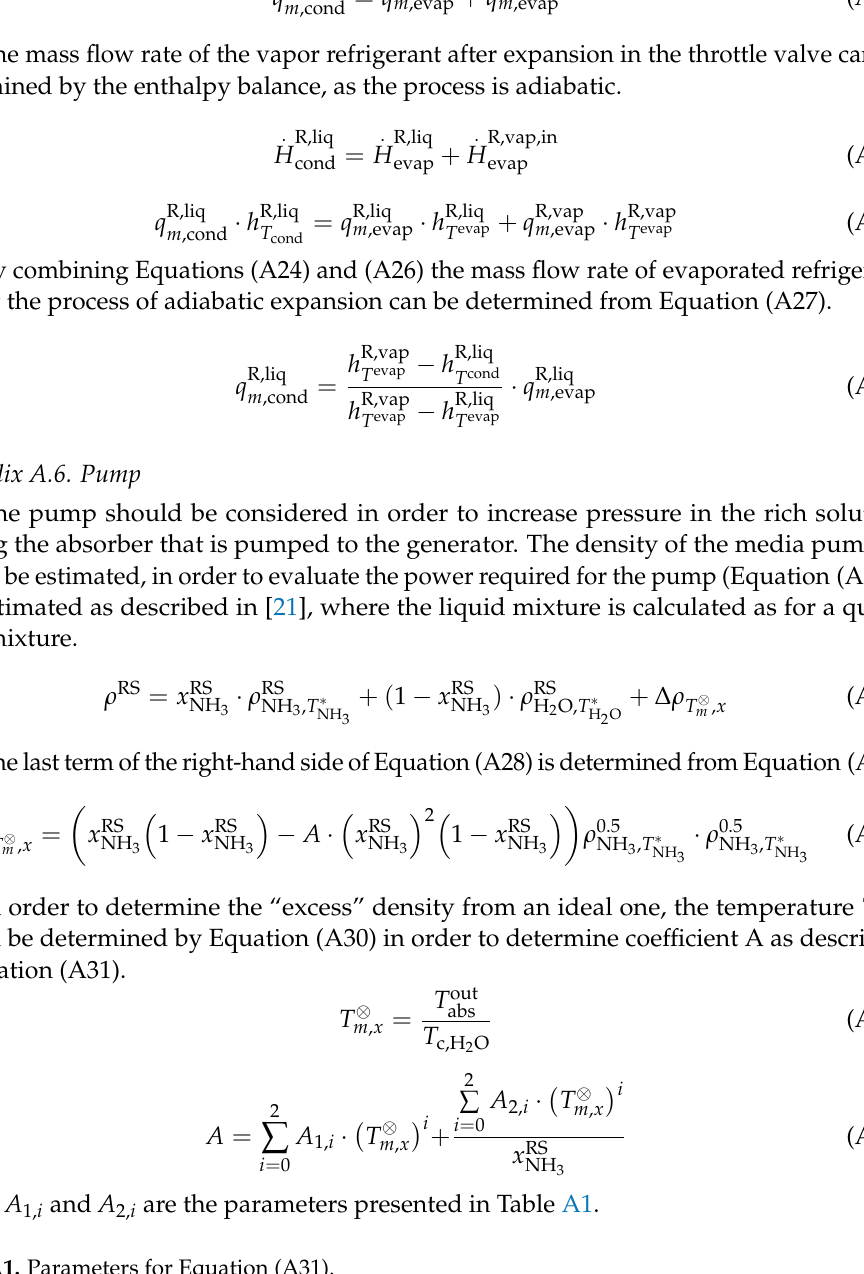
Table A1. Parameters for Equation (A31).